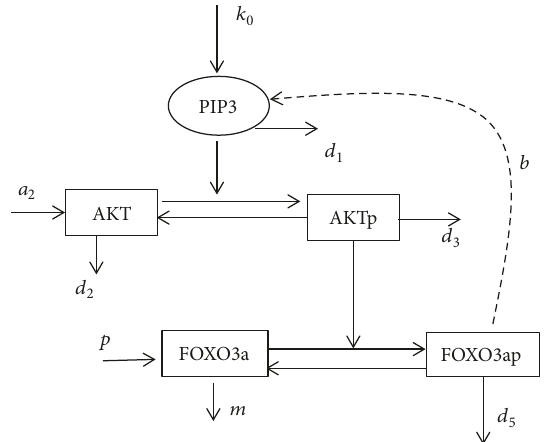
Figure 1: Simplified diagram of PI3K/AKT/FOXO3a